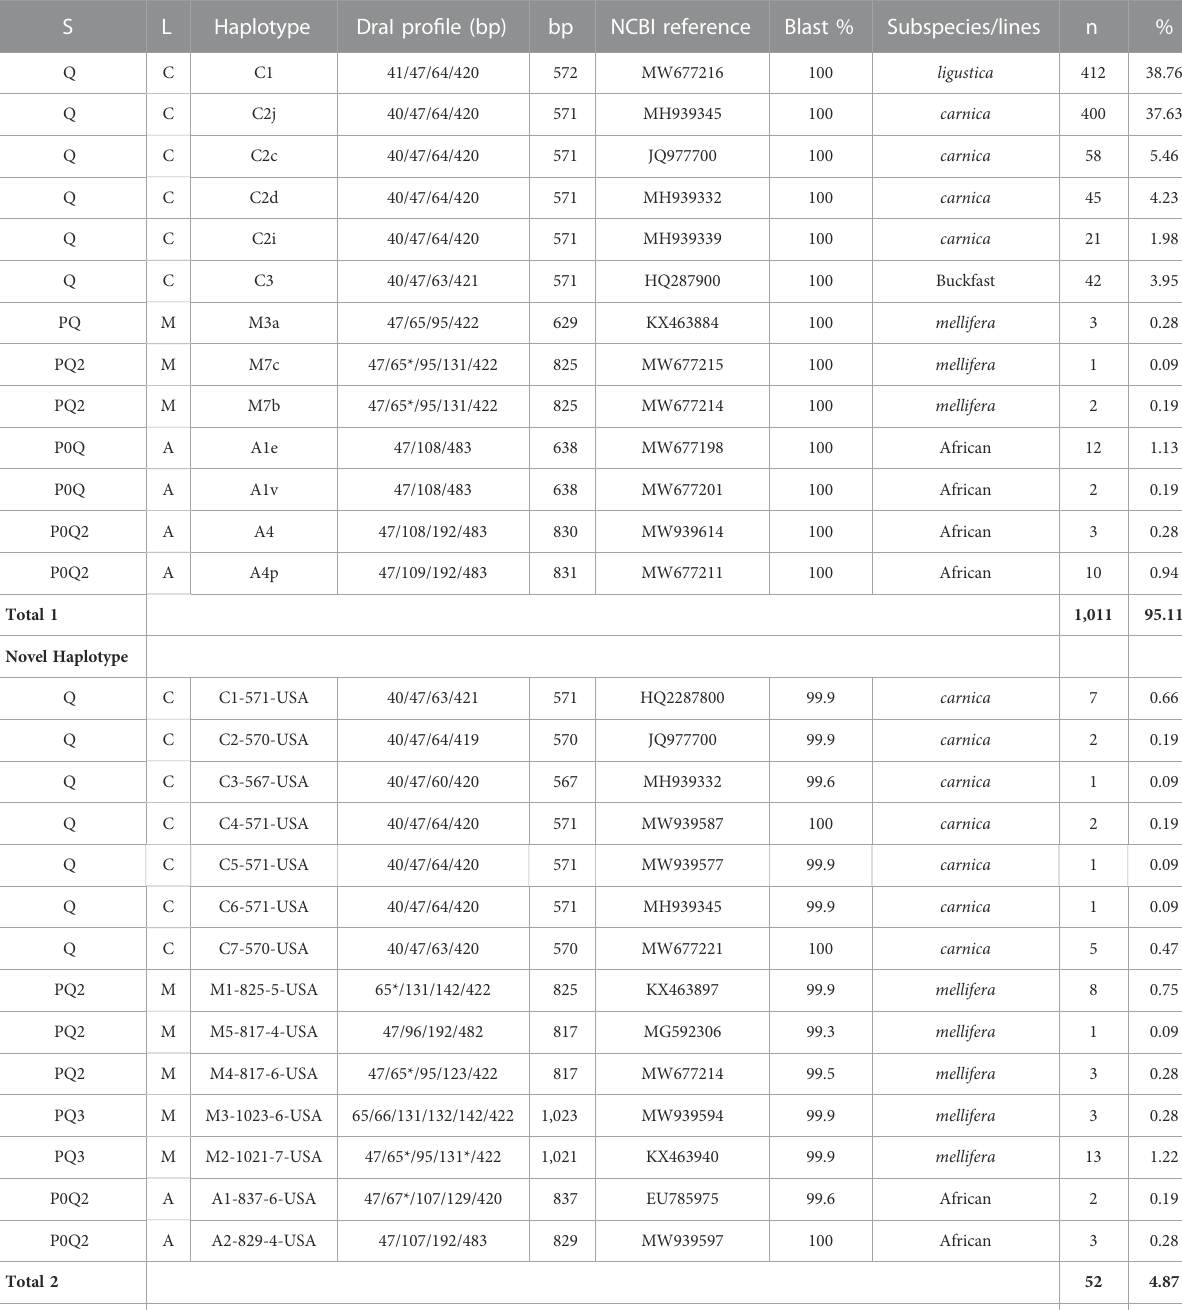
TABLE 1 COI-COII genetic structure (S), evolutionary lineage (L), sequence length (bp), number of samples (n) and overall percentage of each haplotype nationwide(%).(*)indicatesadoublebandofthesamesizeintheDraIpro fi le.Totaloneisforsamplesofpreviouslyidenti fi edhaplotypesandTotaltwoisfor novel haplotypes identi fi ed in the USA